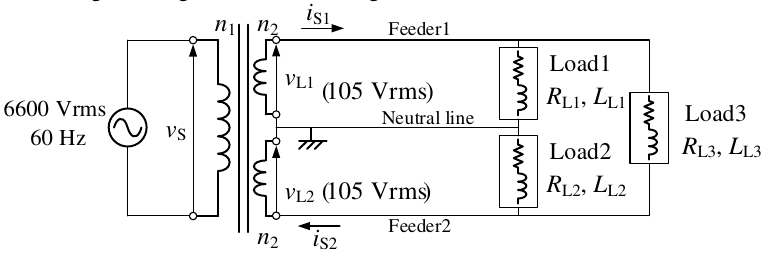
Figure 1. Typical single-phase three-wire distribution feeder (SPTWDF) used in